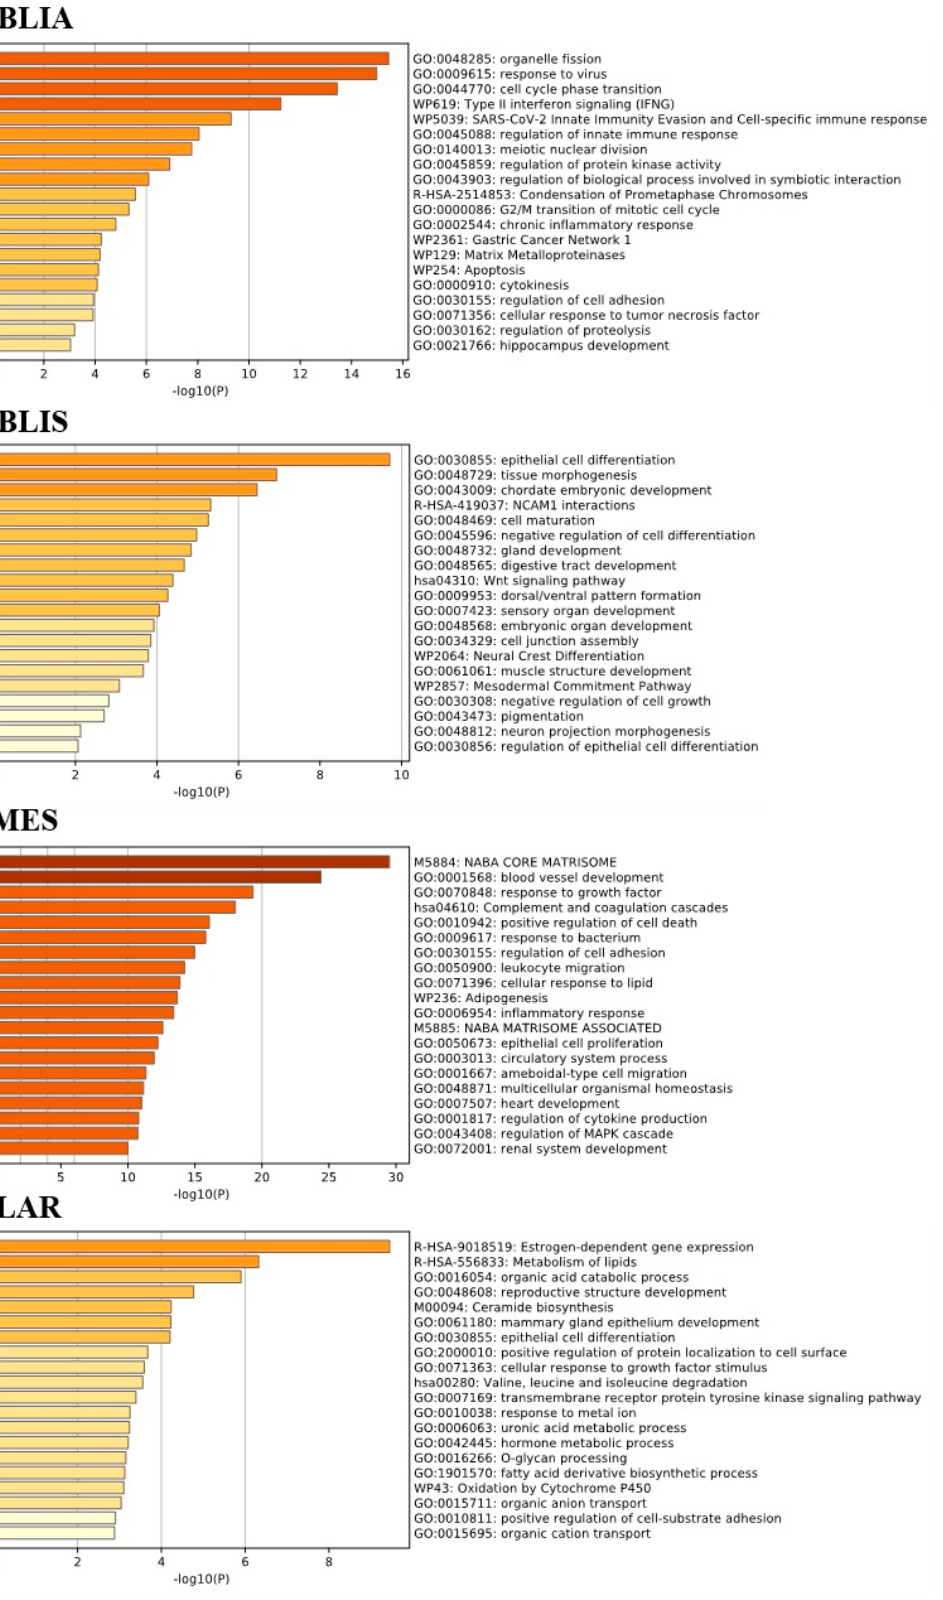
Figure 2. GO term and KEGG pathway enrichment analysis of uniquely upregulated DEGs of each TNBC subtype.